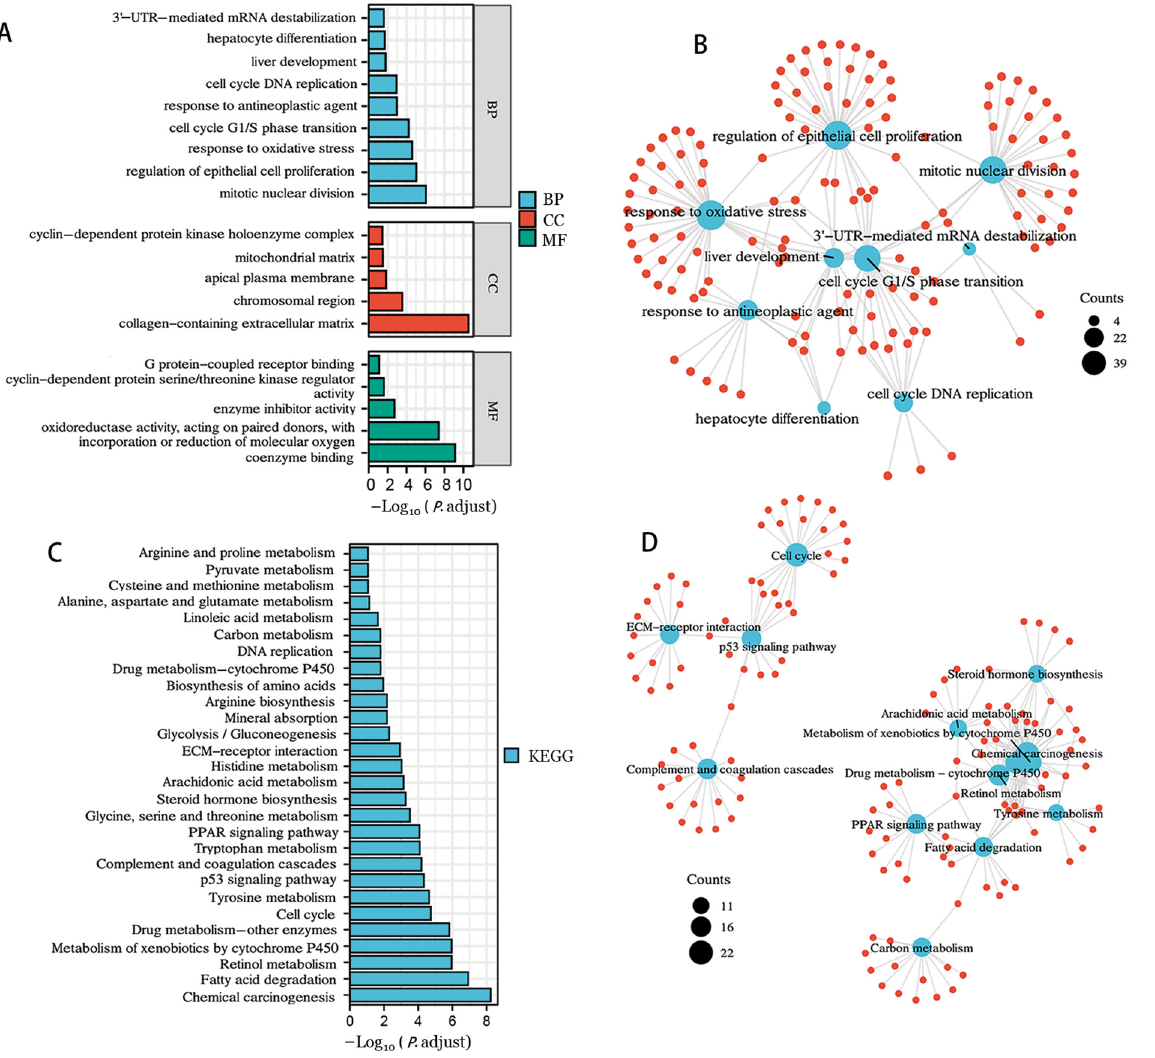
Figure 3. GO and KEGG enrichment analyses of differentially expressed genes in HBV-related HCC. GO term enrichment results ( A , B ). KEGG enrichment results ( C , D ). The blue nodes represent the entries, the red nodes represent the numerators, and the connecting lines represent their rela- tionship.